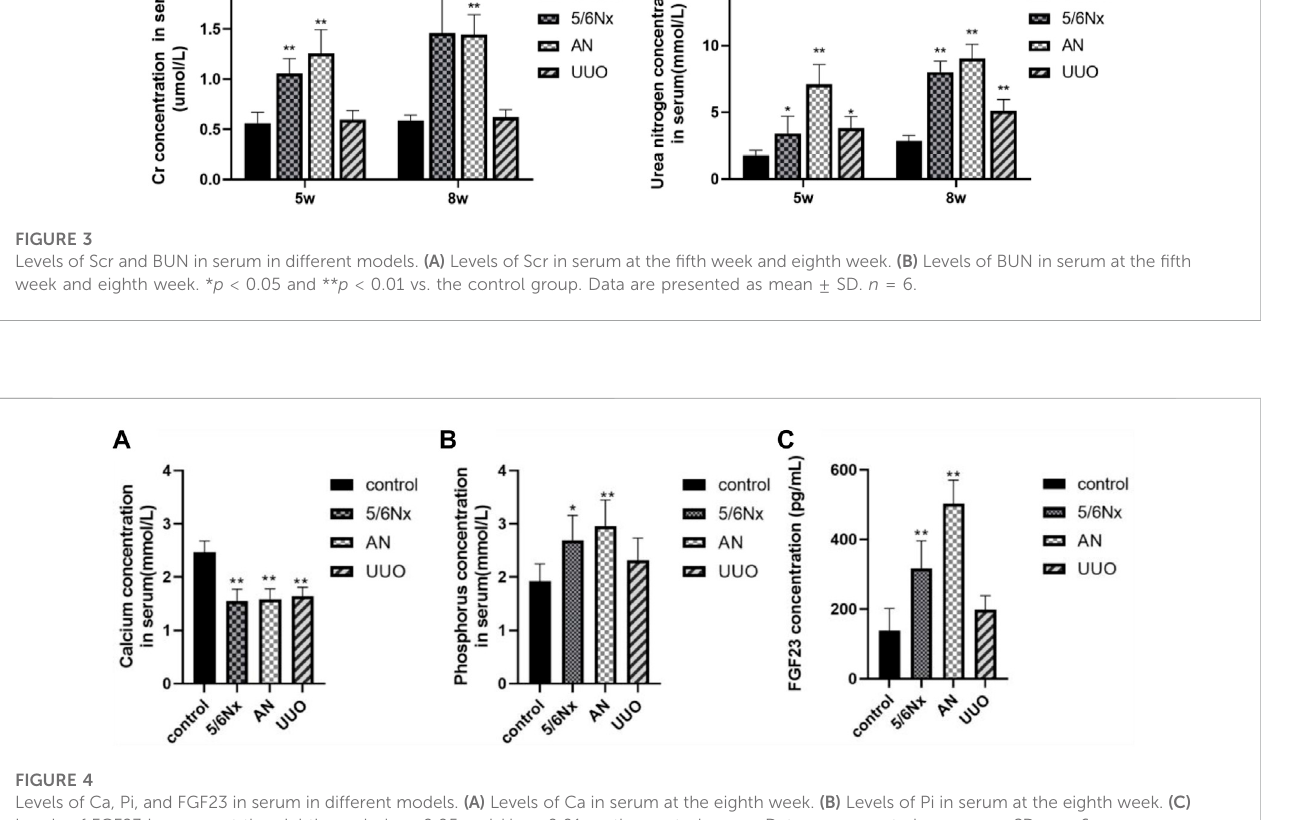
Levels of Ca, Pi, and FGF23 in serum in different models. (A) Levels of Ca in serum at the eighth week. (B) Levels of Pi in serum at the eighth week. (C) Levels of FGF23 in serum at the eighth week. * p < 0.05 and ** p < 0.01 vs. the control group. Data are presented as mean ± SD. n =